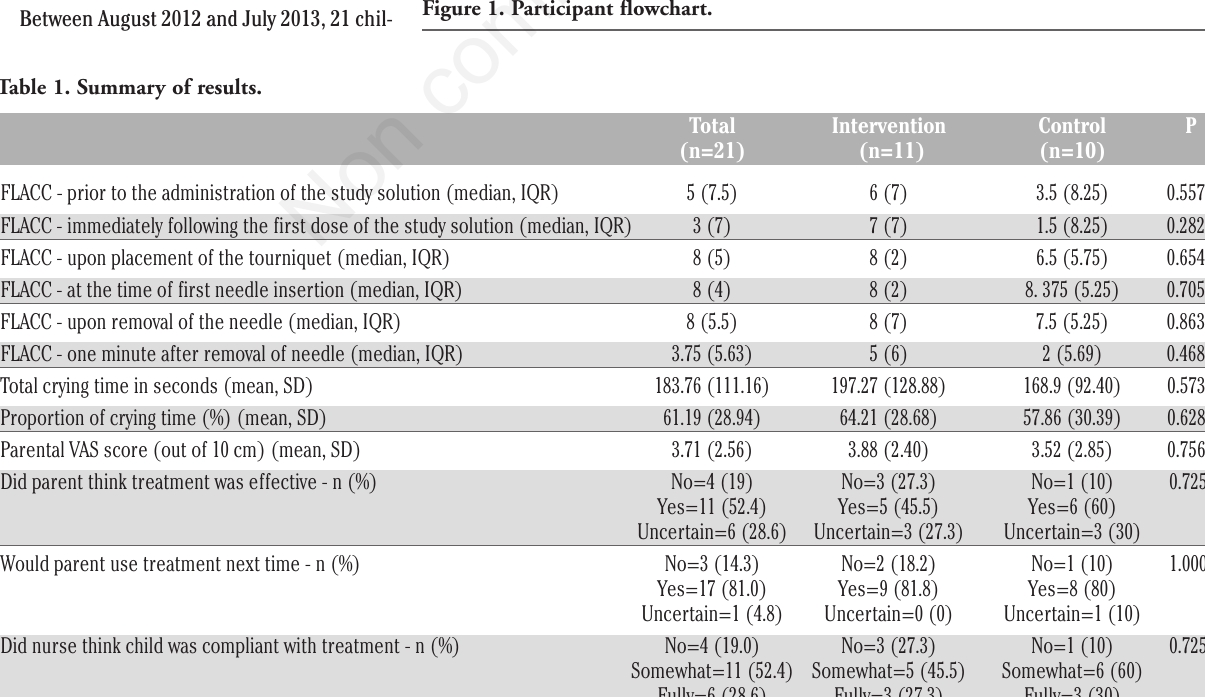
Figure 1. Participant